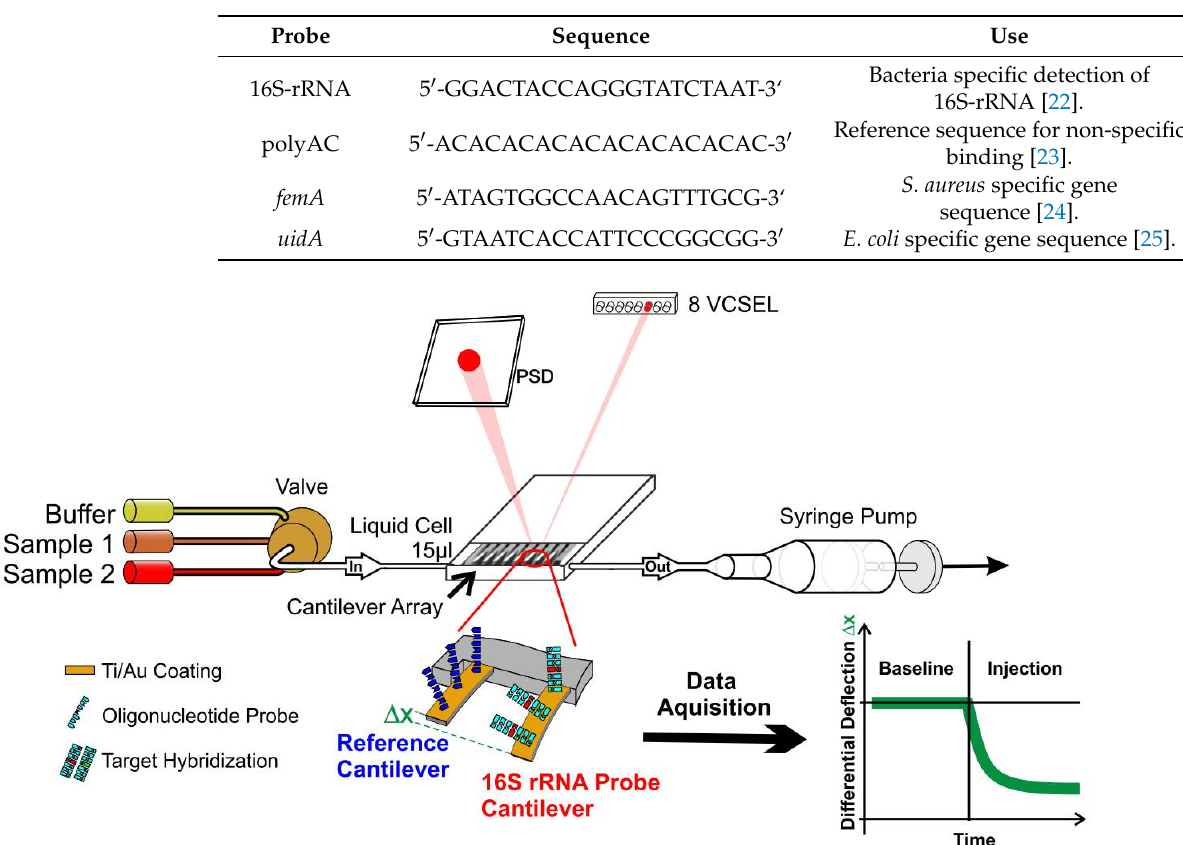
Table 1. Oligonucleotide probes used in the study.